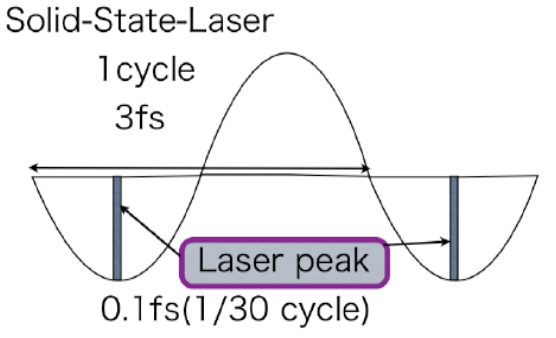
Figure 4. Laser cycle and peak power